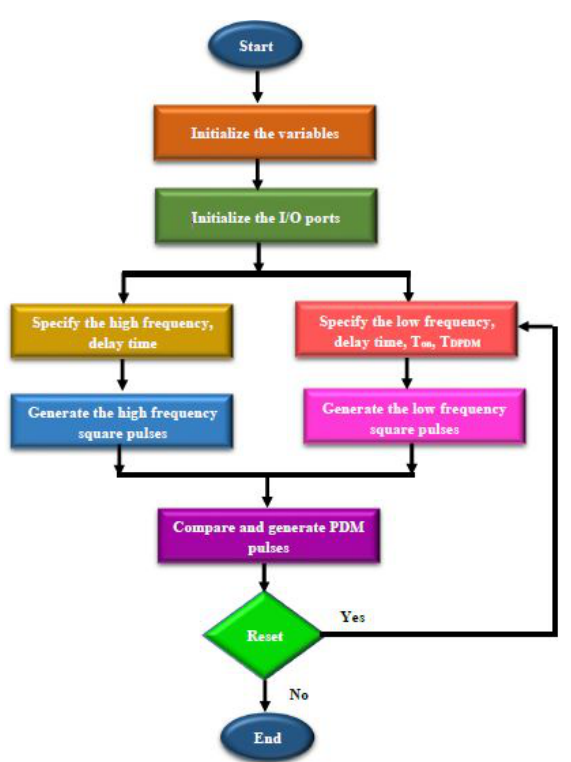
Figure 14. Flow chart of PDM control